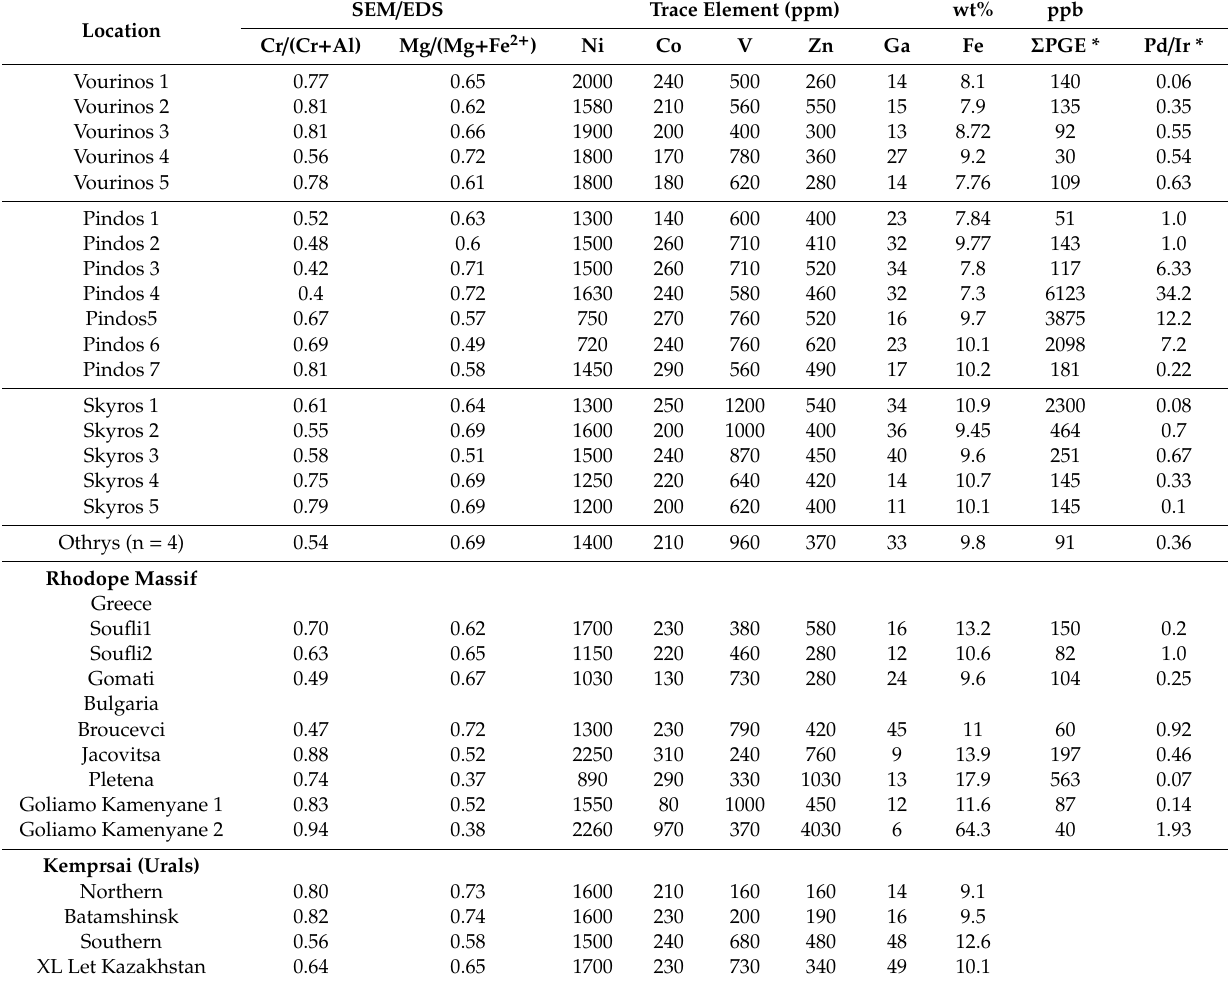
Table 2. Trace element contents of high-Cr and high-Al